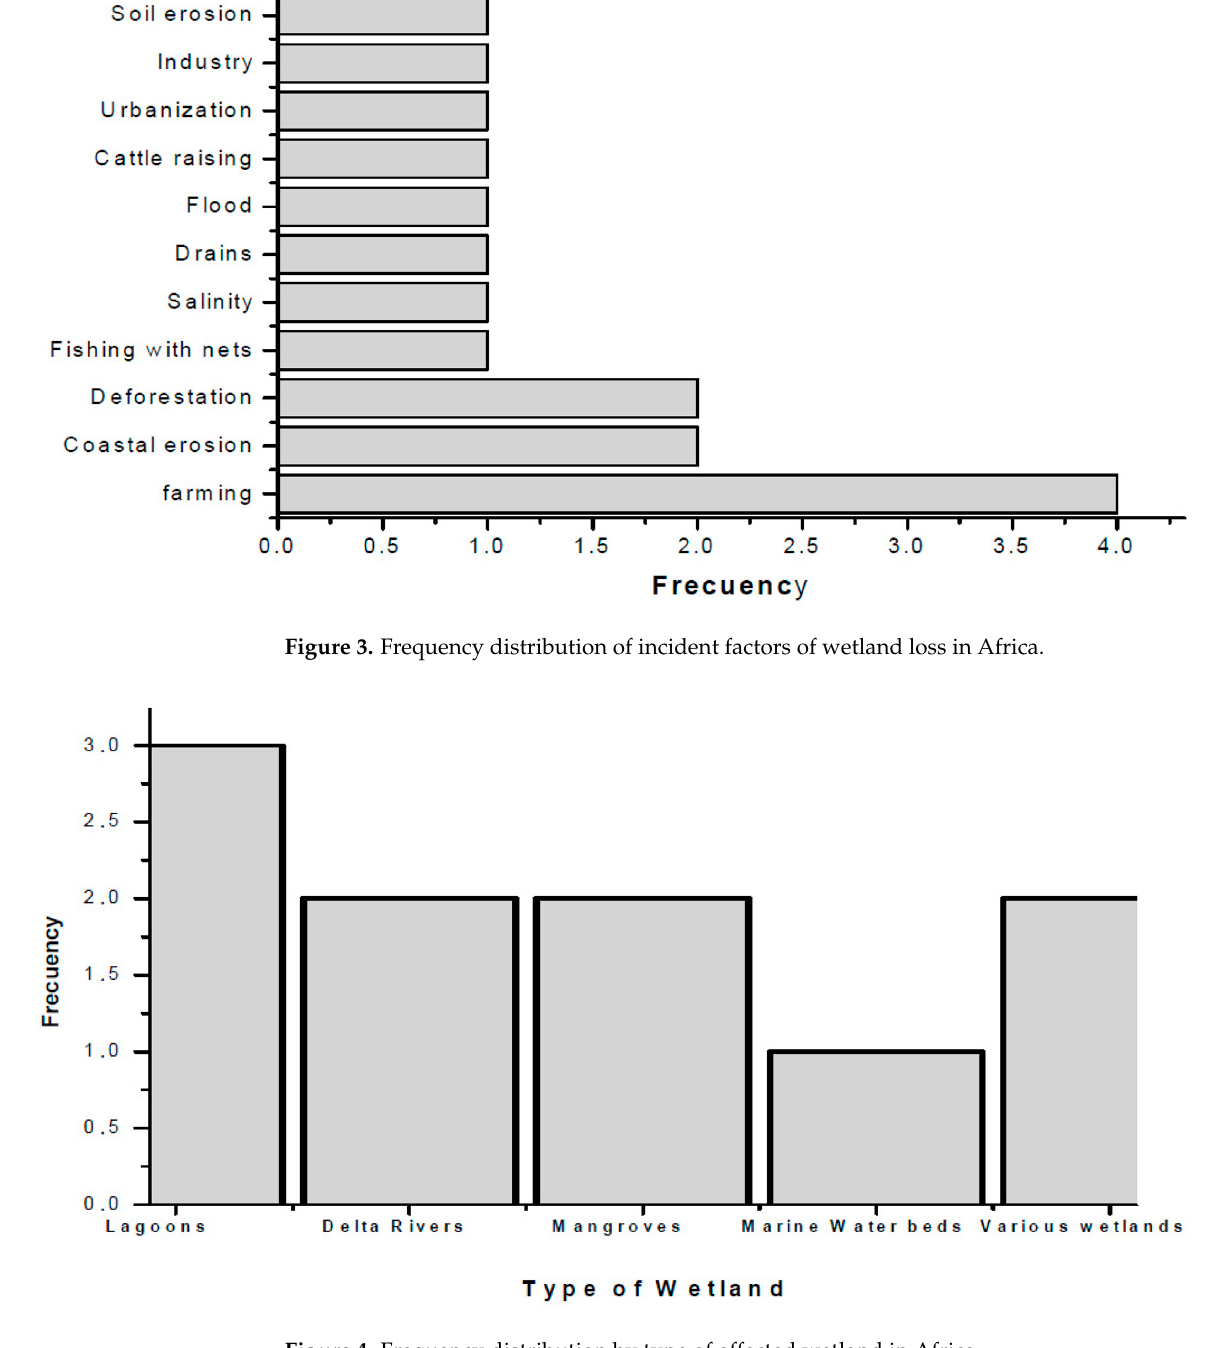
Figure 4. Frequency distribution by type of affected wetland in